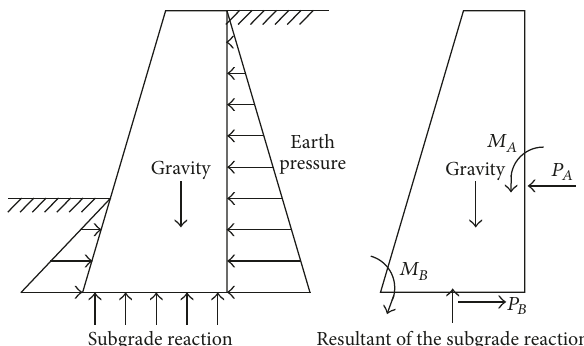
Figure 3: Schematic of the stability analysis of retaining wall